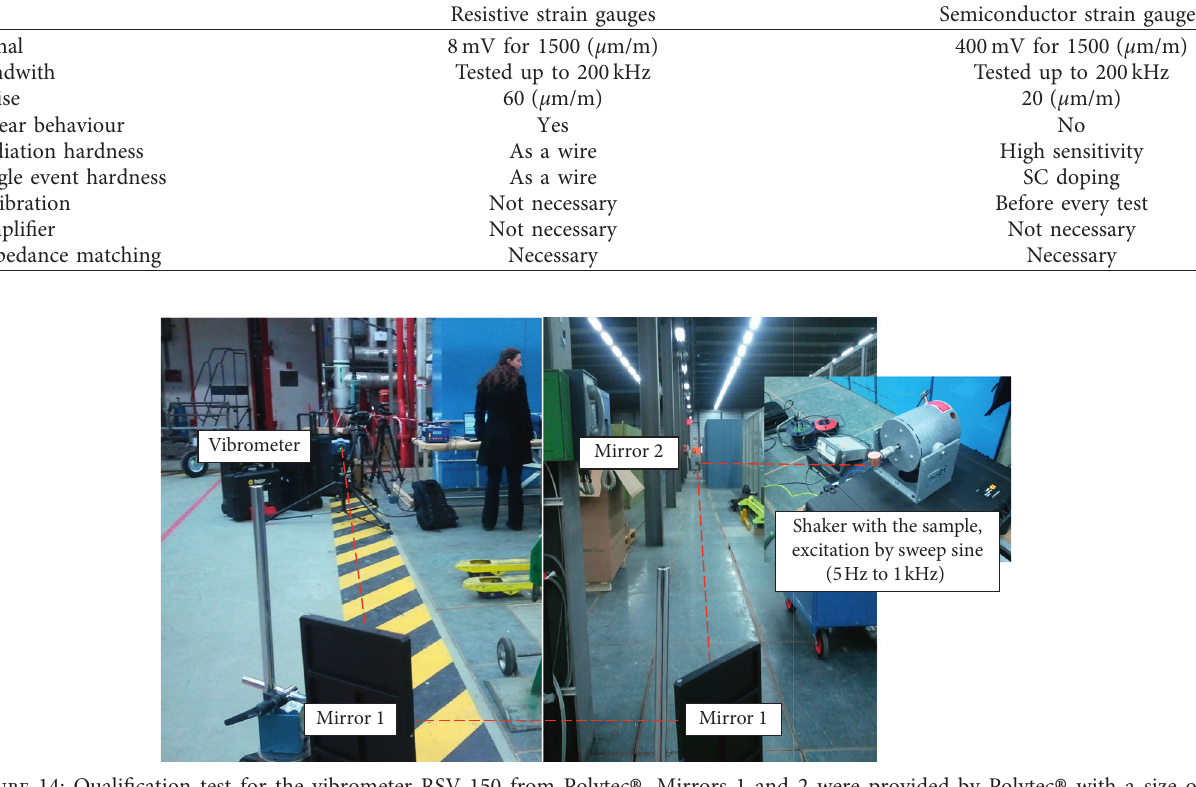
Table 6: SPHB qualification test of strain gauges.